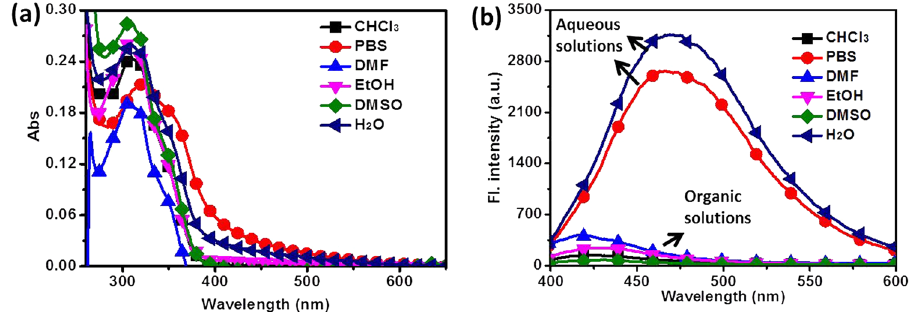
Figure 3. ( a ) The UV–vis absorption and ( b ) fluorescence spectra of TPE-TLE in aqueous solutions and organic solvents. [ TPE-TLE] = 5.0 μ